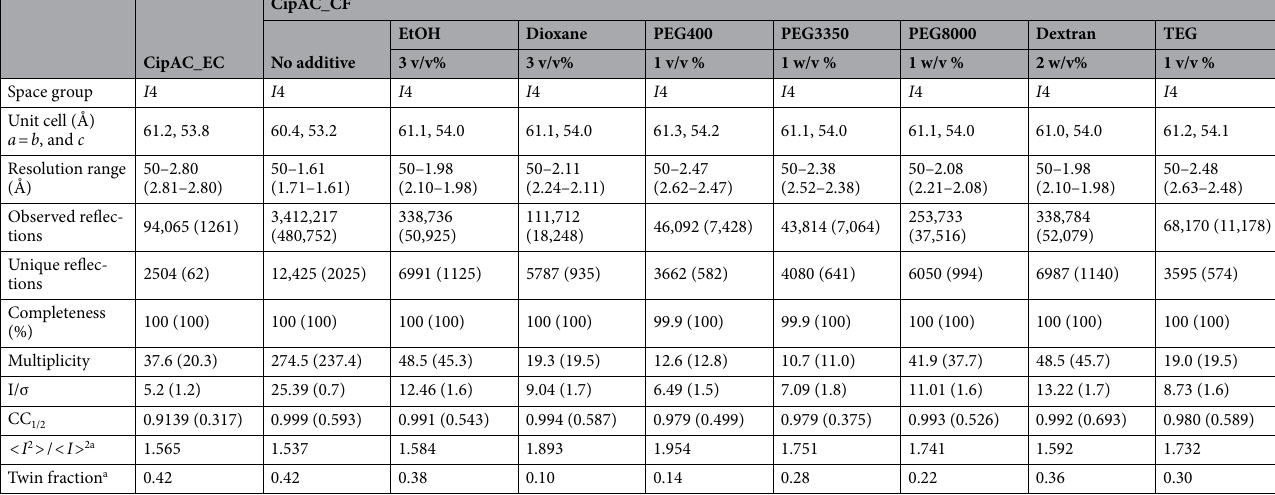
Table 4. Crystallographic data of CipAC_EC and CipAC_CF. a Twinning was analyzed with phenix.xtriage . Values in parentheses are for the highest-resolution